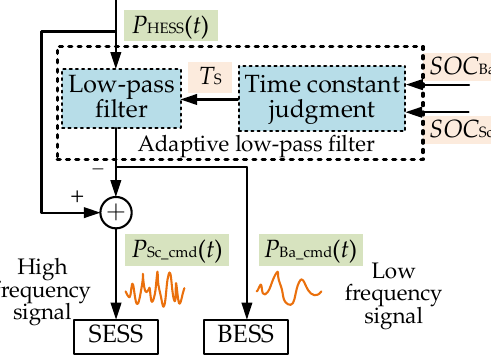
Figure 6. Power allocation strategy of HESS.